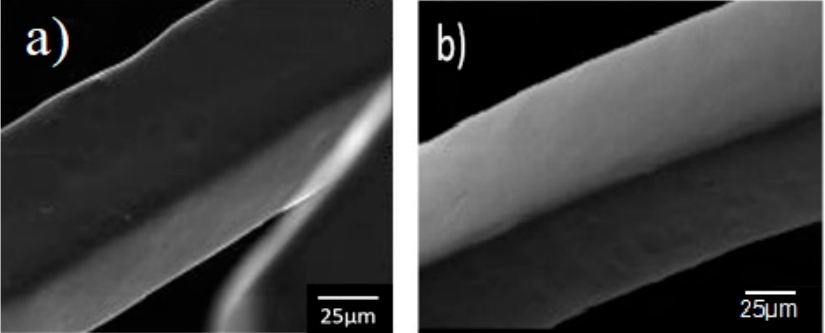
Figure 5. Scanning electron micrography of control stent ( a ) before and ( b ) after 7 days of immersion in KOH solution.